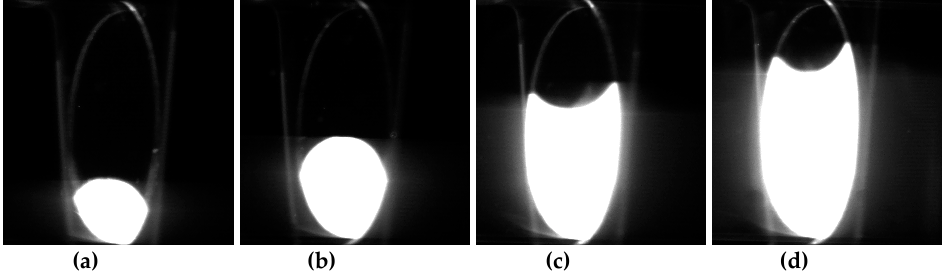
Figure 7. The static liquid-liquid interfaces visualized by the PLIF: ( a ) y a = 20%; ( b ) y a = 40%; ( c ) y a = 60%; ( d ) y a = 80%.